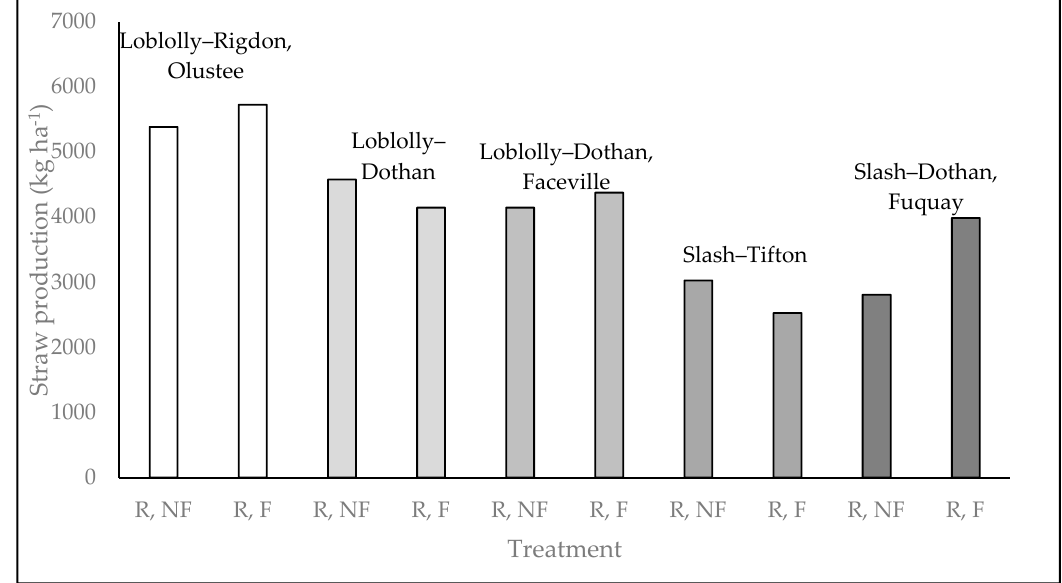
Figure 9. Loblolly and slash pine straw production three years after treatment [25]. Treatments: no rake, no fertilization (NR, NF); rake, no fertilization (R, NF); no rake, fertilization (NR, F); rake, fertilize (R, F) (refer to Tables 6 and 7 for study details, information on fertilizer treatments, and statistical test results).